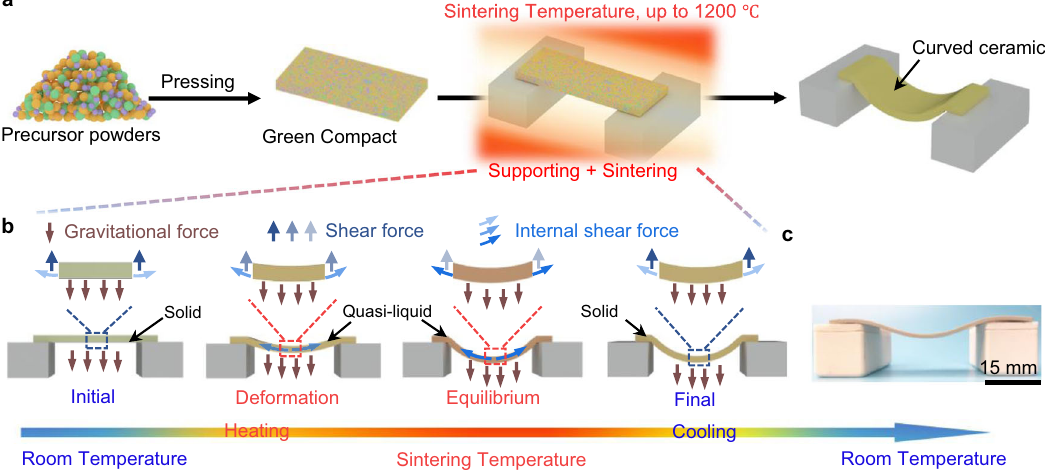
Fig. 1 Gravity-driven sintering (GDS) process and setup for the ceramic synthesis. a Schematic of the GDS synthesis process, in which the pressed green compact is placed on two alumina supports and sintered into a dense ceramic. b Schematic of the mechanism of the GDS process, in which the force equilibrium in the initial stage is broken in the deformation stage due to the quasi-liquid state of the sintering specimen under high temperature. In the equilibrium stage, a new force equilibrium forms and the curved con fi guration maintains to the fi nal stage. c Photograph of the fabricated PZT ceramic in a curved Table 1 Comparison of processing methods for fabricating compact piezoceramics with complex geometries by the GDS process, 3D printing, and post-processing methods.